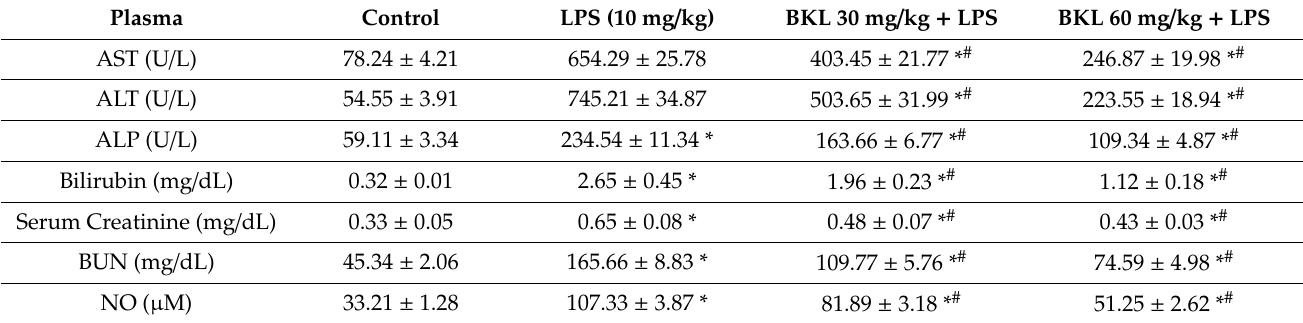
Table 2. E ff ect of bakuchiol pretreatment on plasma markers in lipopolysaccharides (LPS)-induced